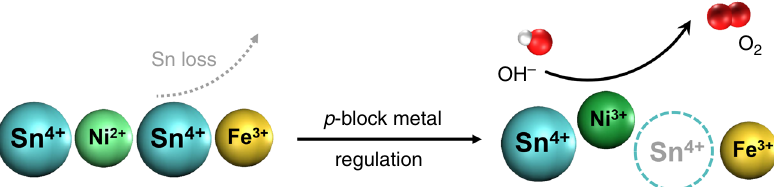
Fig. 1 Schematic of p -block metal regulation of perovskite electrocatalysts for OER. Sn 4+ dissociates from SnNiFe perovskite host and leaves in situ vacant sites during the p -block metal regulation. The surface vacant sites possess high intrinsic reactivity for water